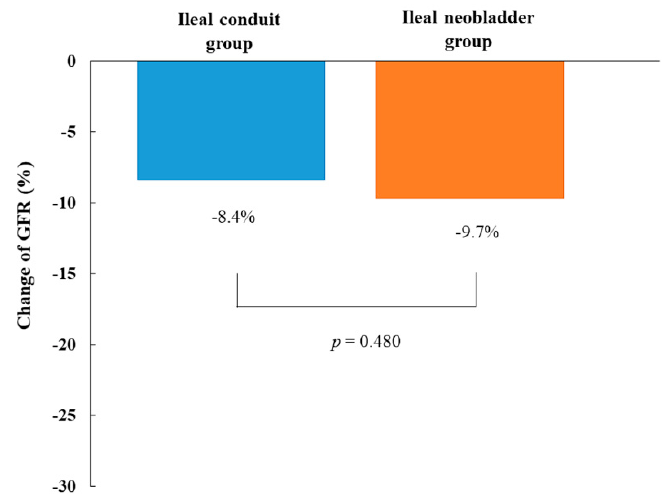
Figure 3. Comparison of the change of GFR between ileal conduit group and ileal neobladder group 12 months after radical cystectomy. The change of GFR was defined as (GFR at 12 months after radical cystectomy—GFR at baseline)/GFR at baseline × 100. Note that the change of GFR was not significantly different between the two groups. GFR, glomerular filtration rate.